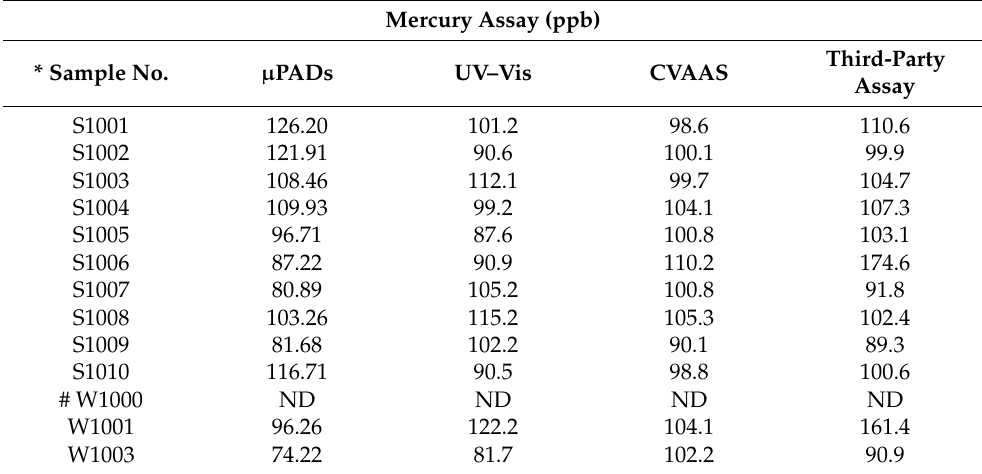
Figure 4. ( A ) RGB and ( B ) R+G+B standard straight curves of paper-based detection systems for mercury by using silver nanoparticles. Table 1. Mercury assay results in comparison of different methods, using µ PADs, UV–Vis spectrum, CVAAS, and third-party corporation for determination of mercury